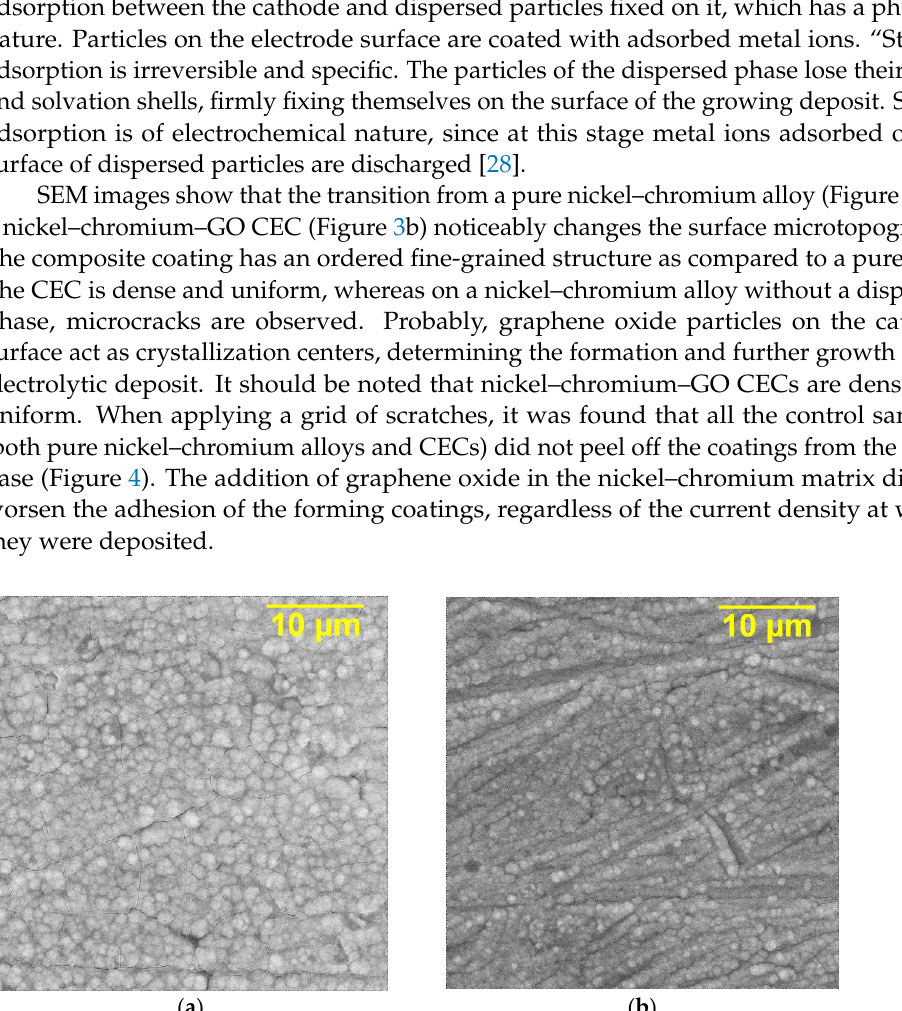
( a ) ( b ) Figure 4. The scratches on the surface of the nickel–chromium alloy ( a ) and the CEC nick- el–chromium–GO ( b ) deposited at cathodic current density i C = 10 A/dm 2 . Magnification x100. The addition of a dispersed phase into a galvanic coating results in the change of not only its composition and structure, but also of its operational properties. In practical terms, the physical and mechanical characteristics of metal surfaces, in particular their microhardness, are of significant interest. The study of nickel–chromium–GO CECs by laser microspectral analysis showed that the carbon content in them increases when moving from the substrate to the surface (Figure 5). Besides, the chromium content in the surface layers of the studied composite coatings increases, which should affect their hardness. In out study, with an increase in the cathode current density, an increase in the microhardness of nickel–chromium alloys was observed (Table 2). This is probably due to the inclusion of hydrogen and hydroxides into the deposit, leading to deformation and compression of the coating crystals [21]. As noted above, the addition of a dispersed phase of graphene oxide in nickel–chromium deposits led to their compaction and the formation of fine-crystalline coatings whereas on a pure nickel–chromium alloy mi- crocracks were observed (Figure 3a,b). Therefore, there was an increase in the micro- hardness of the nickel–chromium–GO CECs in comparison with pure alloys (Table 2), regardless of the electrolysis mode. It is known [1,2] that an important role in the en- hancement of the microhardness of the CECs is played by the straightening of the crys- tallographic orientation and crystalline refinement. Thus, we can assume that during electrochemical deposition of the nickel–chromium–GO composite coatings graphene oxide particles brought about the crystalline refinement and decreased texture of formed deposits.